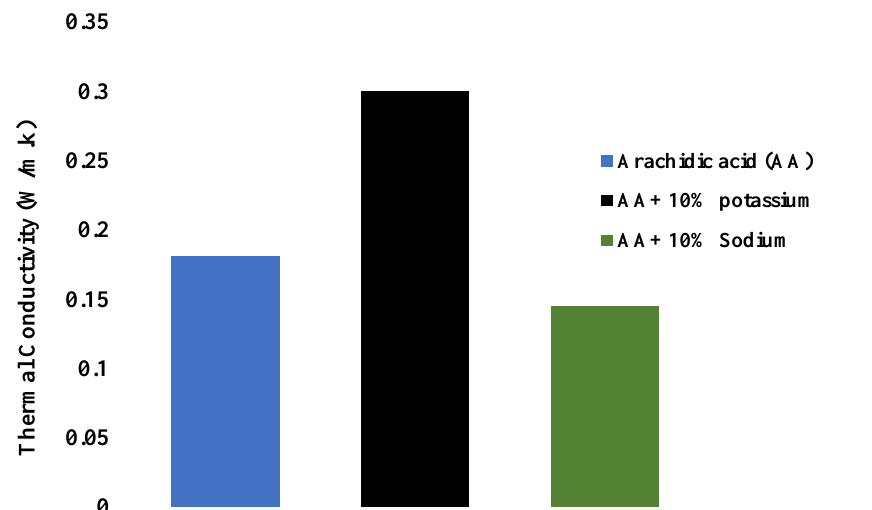
Figure 6. Thermal conductivity of Arachidic acid and its mixtures.